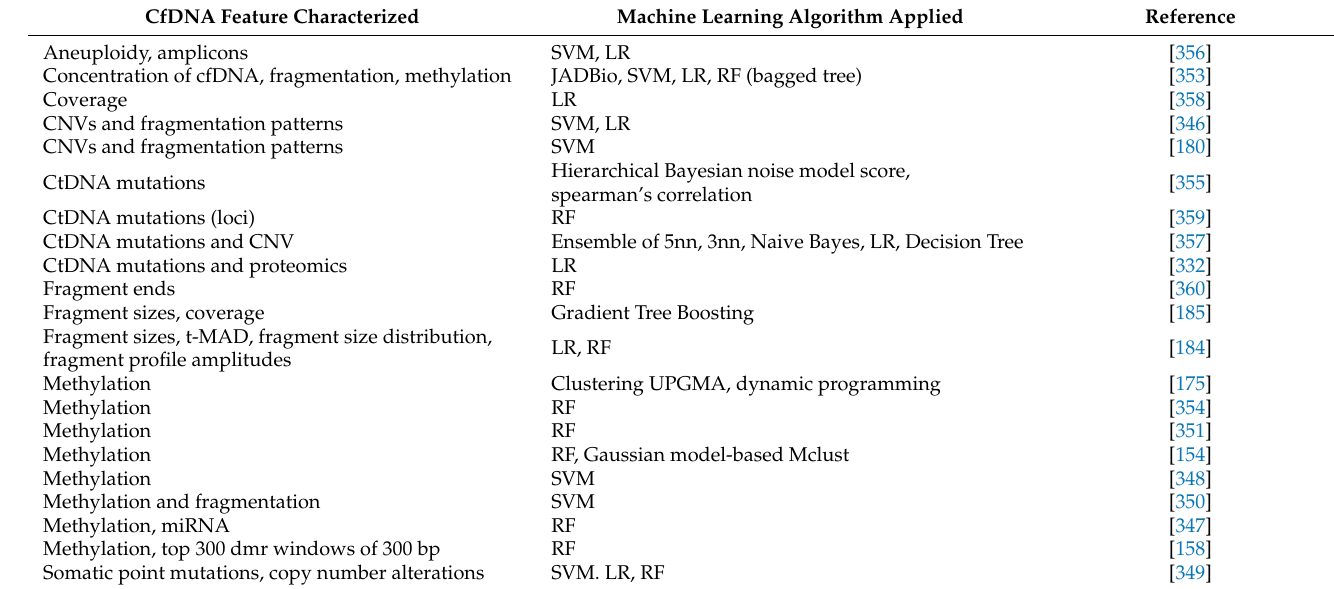
Table 3. Cell-free DNA (cfDNA) studies that employed machine